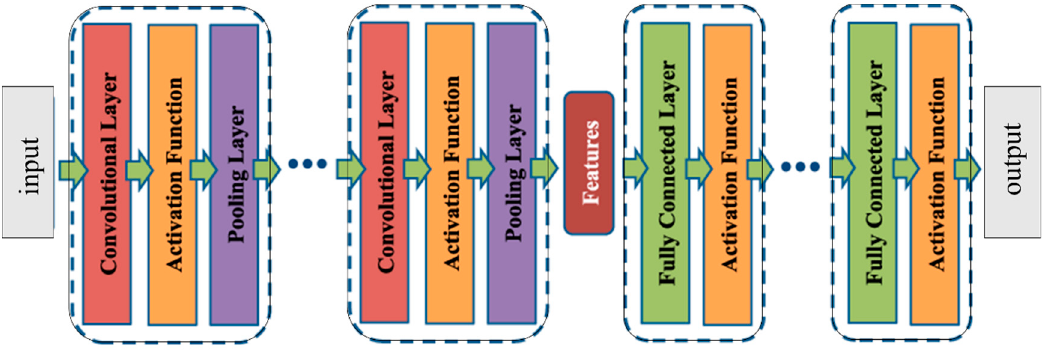
Figure 4. The general architecture of convolutional neural network (CNN).